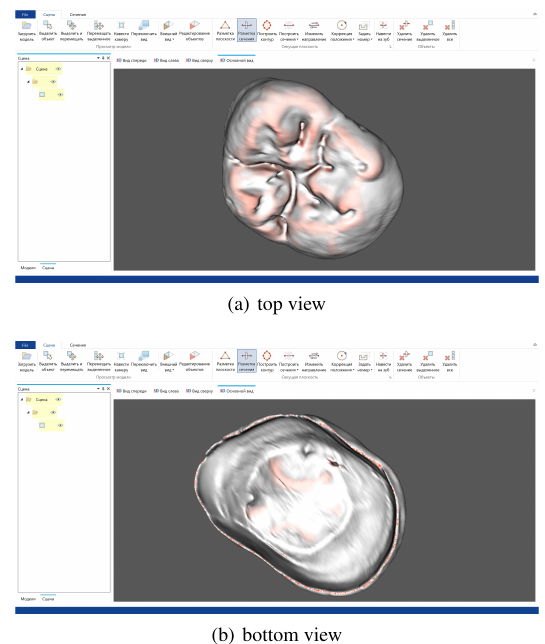
Figure 1. Enamel cap of upper right third molar, C2 Suhghir; top view (a) and bottom view